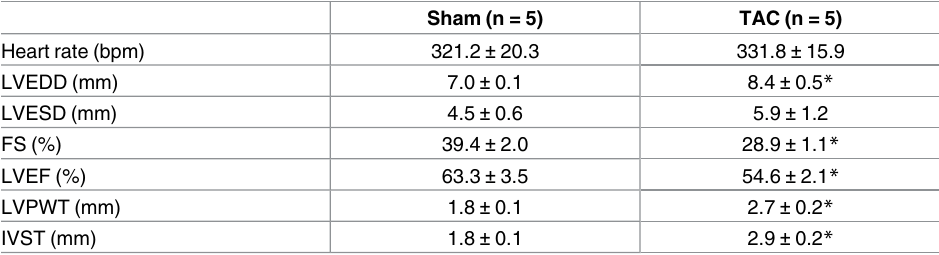
Table 1. Echocardiography of sham-operated and TAC-operated rats.